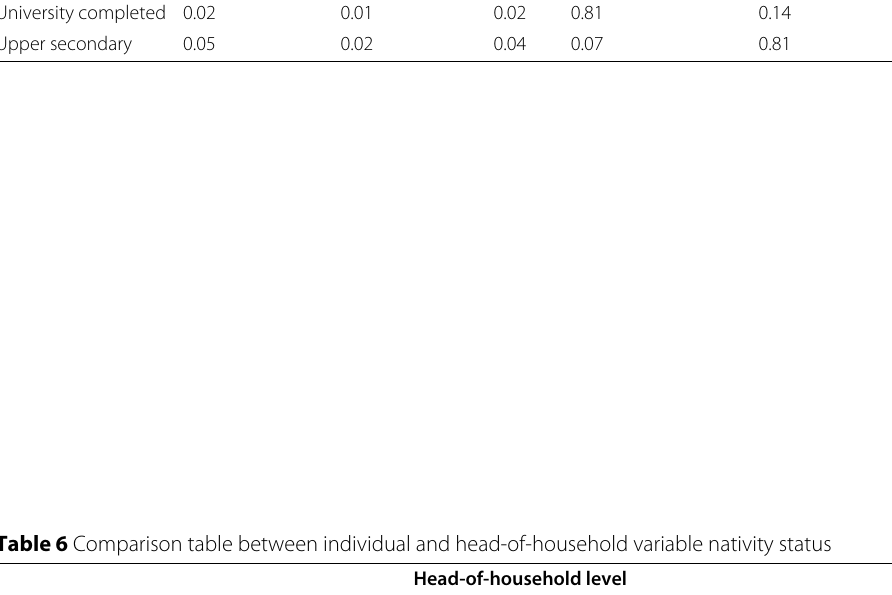
Head-of-household level